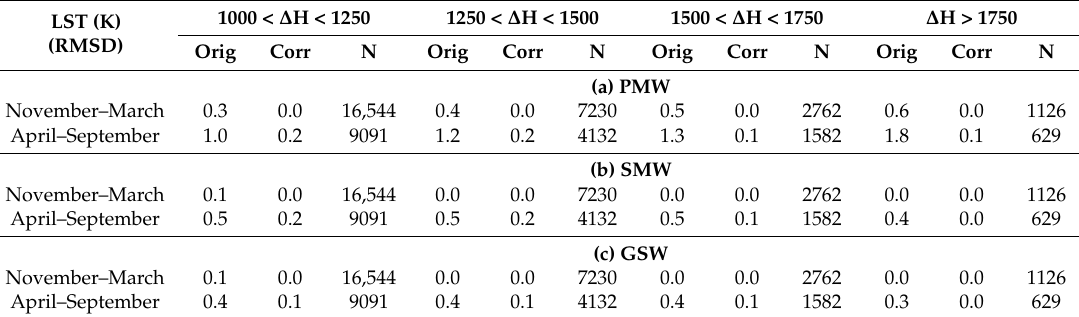
Table 1. Land surface temperature (LST) root mean square difference (RMSD) (K) when comparing LST derived with COSMO profiles (reference) and LST derived with ERA-Int original profiles (Orig) and ERA-Int corrected with the different methods (Corr), for a physical mono-window (PMW) ( a ), statistical mono-window (SMW) ( b ), and generalized split-windows (GSW) ( c ). N represents the number of profiles in a determined class of altitude difference and season. The seasons are extended winter (November–March) and extended summer (April–September). 1000 < ∆ H < 1250 1250 < ∆ H < 1500 1500 < ∆ H < LST (K) (RMSD)